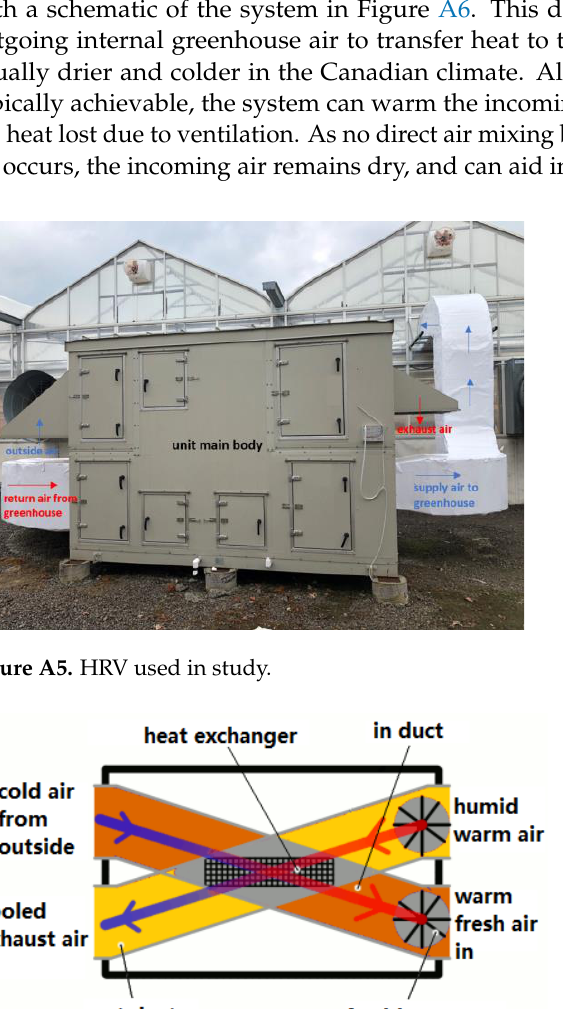
Figure A4. Schematic of LDD functionality.